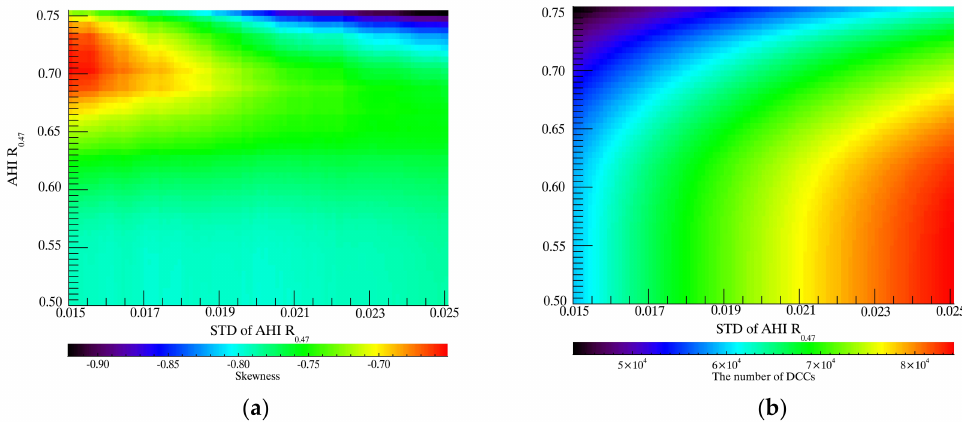
Figure 12. ( a ) Skewness and ( b ) the number of DCCs as a function of the AHI R 0.47 and uniformity test for DCC detection using DCC measurements for July 2018–June 2019 taken at 5-day